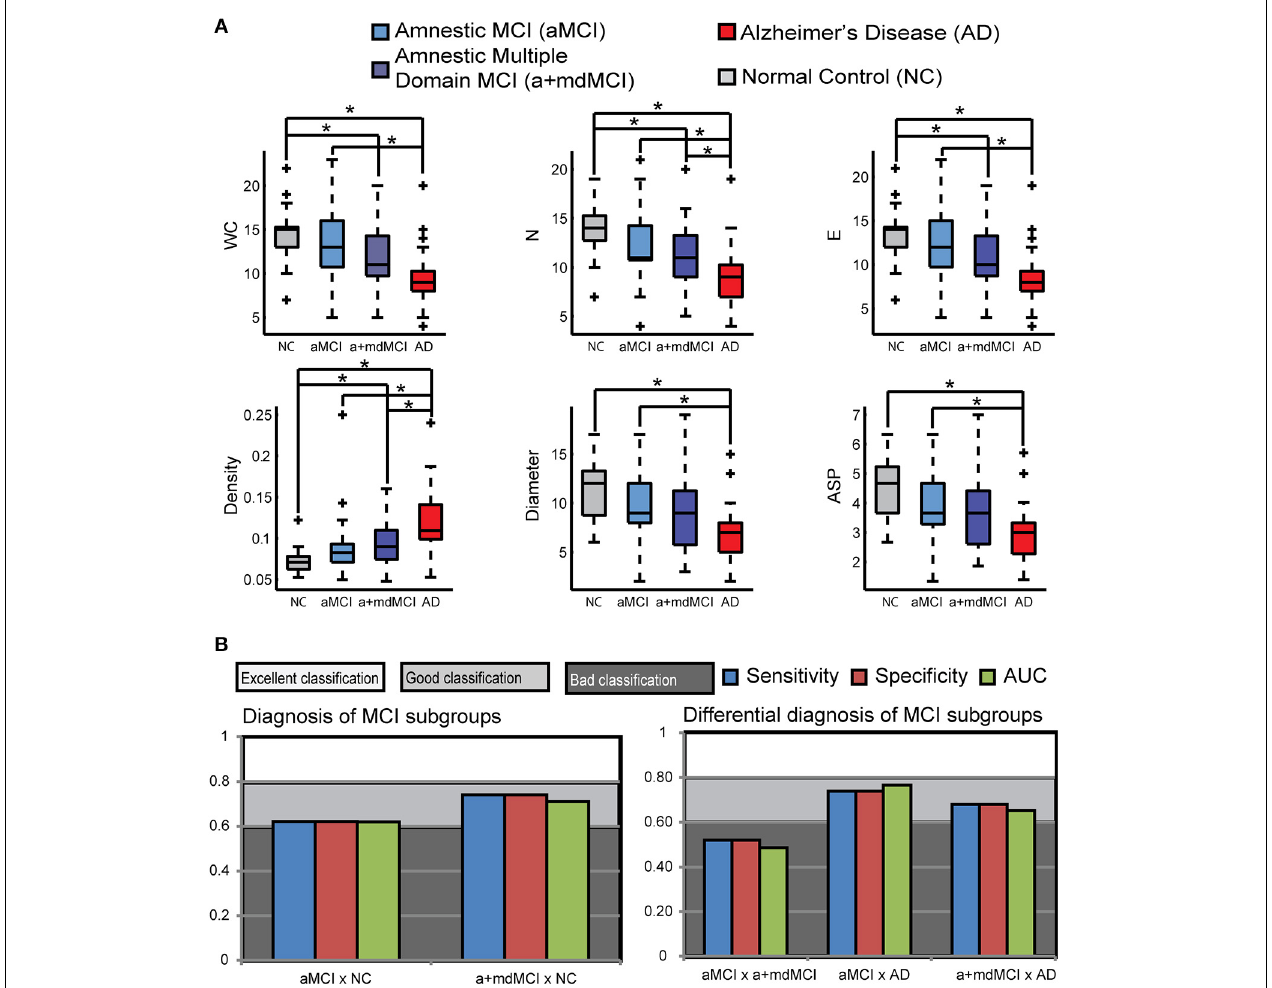
FIGURE 3 | Speech Graph Attributes (SGA) differentiates psychopathological MCI subgroups. (A) SGA boxplots with significant differences among Alzheimer Disorder (AD), Amnesic Moderate Cognitive Impairment (aMCI), Multiple Domain Moderate Cognitive Impairment (a + mdMCI), and control groups indicated ( N = 25 per group; Kruskal-Wallis test followed by two-sided Wilcoxon Rank-sum test with Bonferroni correction with alpha = 0.0083). (B) Rating quality measured by AUC,